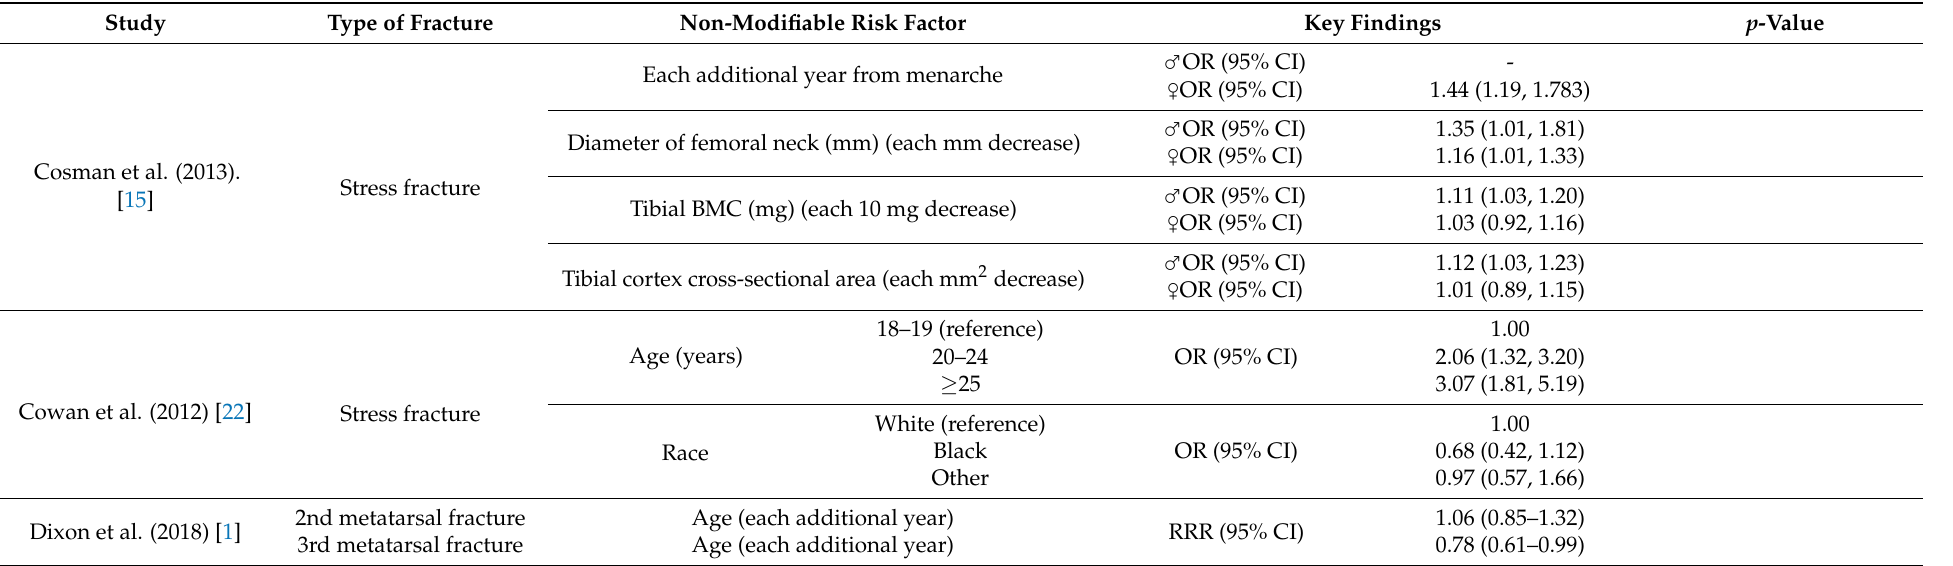
Table 4. Non-modifiable risk factors and associated relative risks or odds of stress